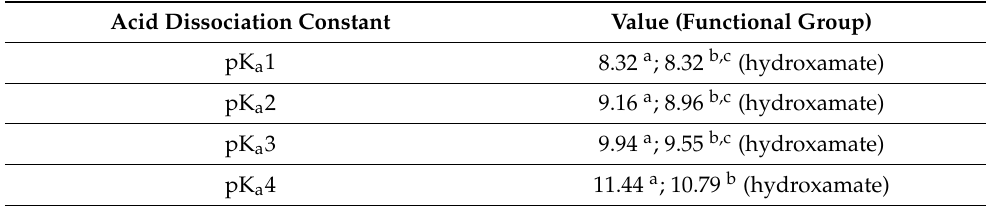
Table 1. Acid dissociation constant (pK a ) values of the hexadentate ligand DFO-B in accordance with the functional groups involved, adapted by ( a ) [35], ( b ) [25] and ( c )